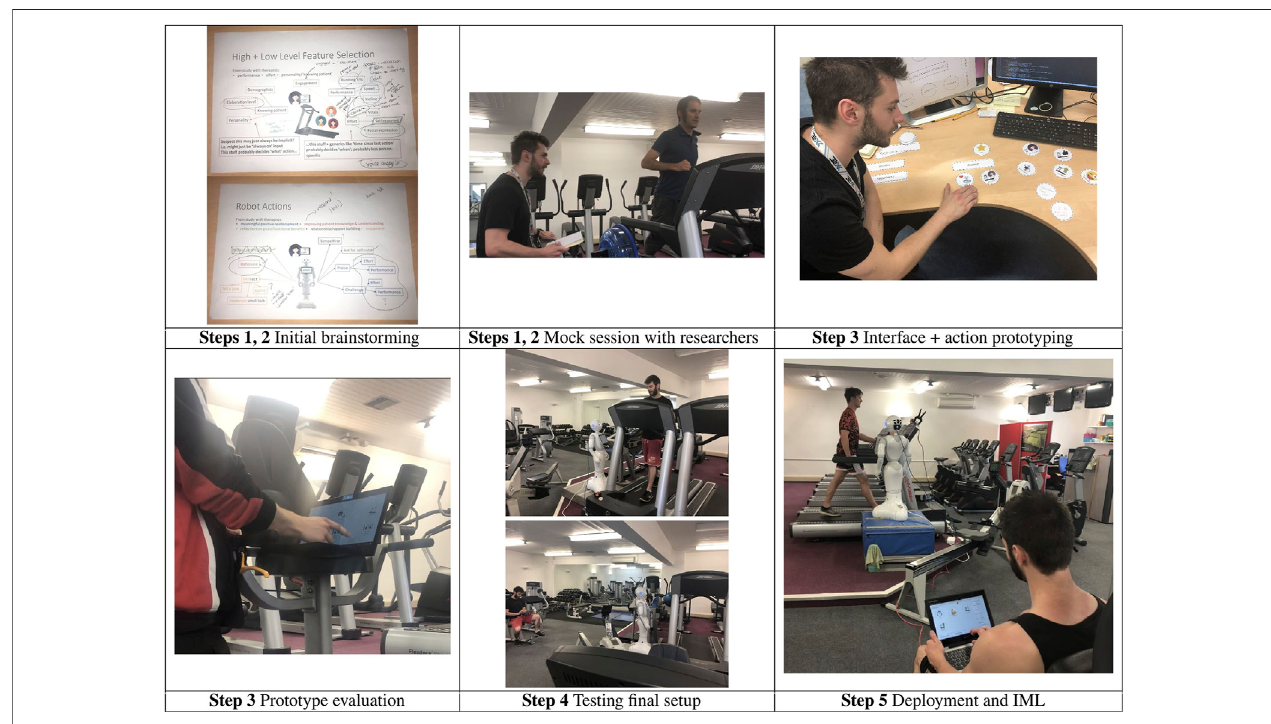
FIGURE4| Pictorialrepresentationsoftheparticipatorydesignactivitiesand fi nalteachingsetupundertakeninapplicationofourmethodtotherobot fi tnesscoach by Winkle et al. (2020), as per Table 2 with reference to Steps 1 – 5 of our method as per Figure 1 .